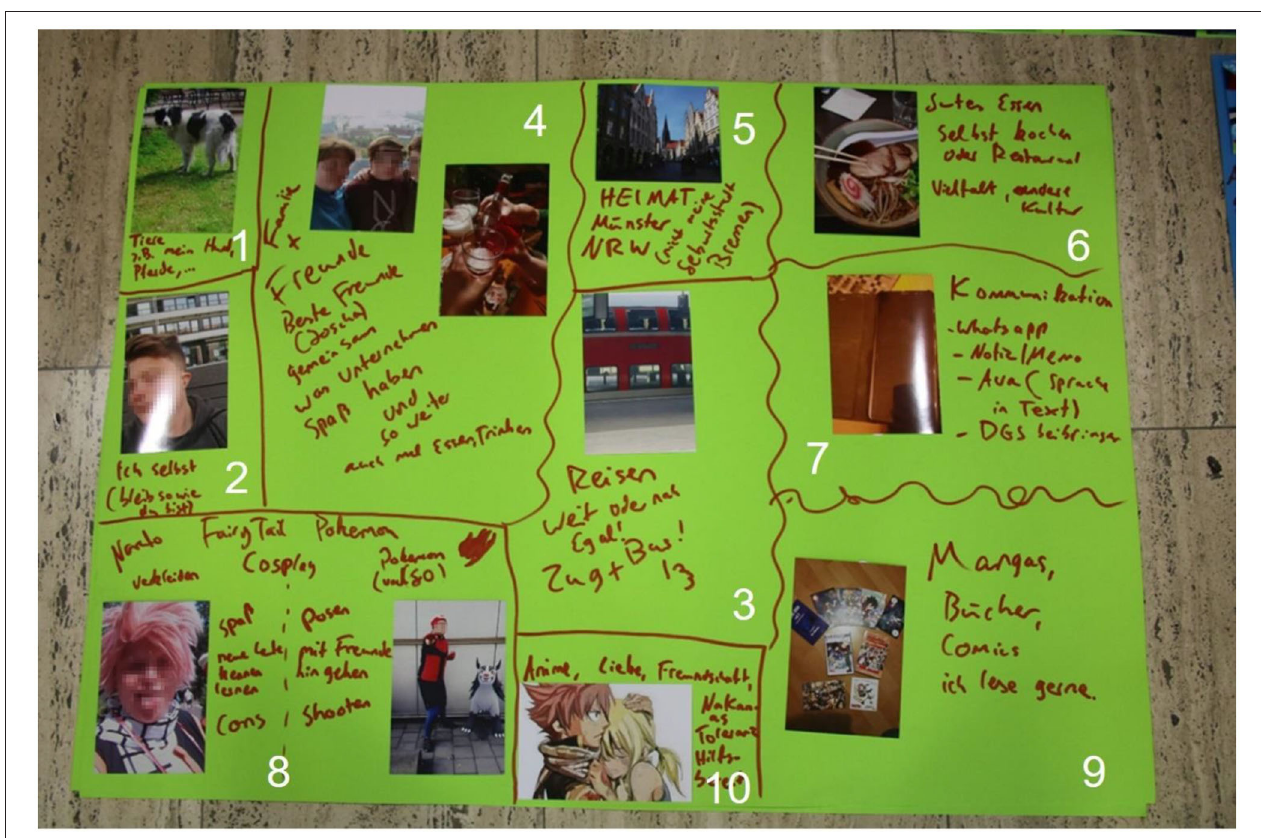
FIGURE 3 | Collage of